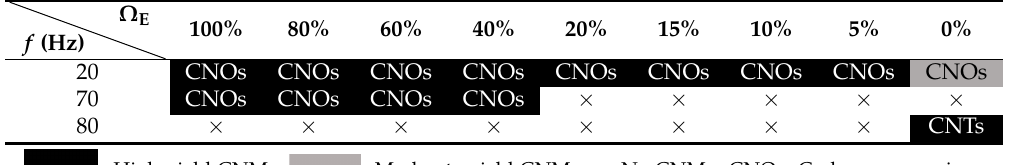
Table 1. Production yield of the carbon nanomaterials under different experimental